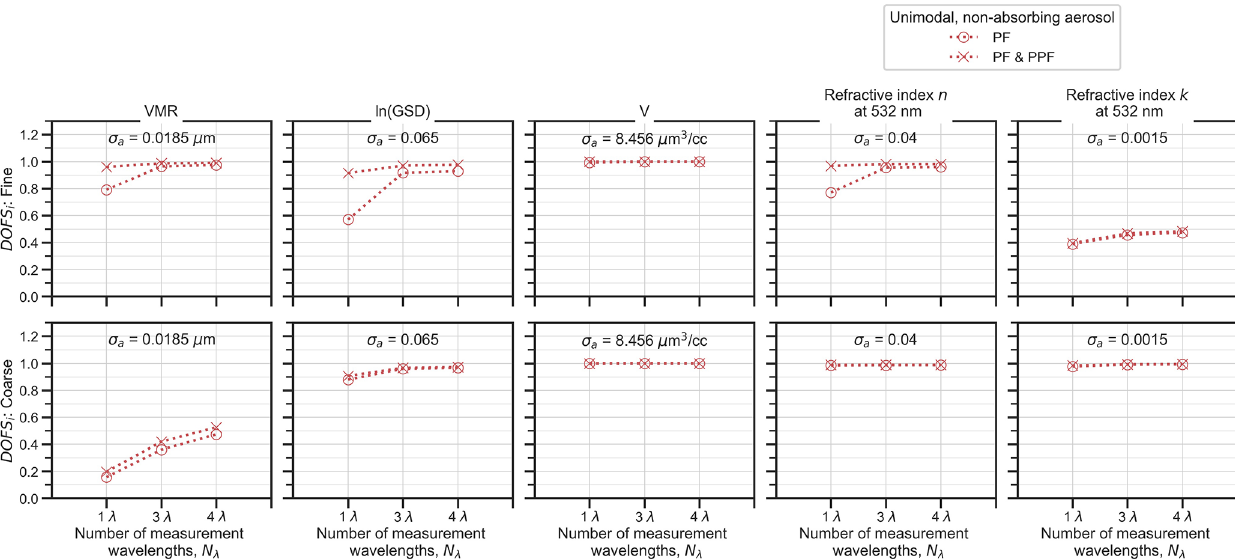
Figure 4. DOFS i values for specific aerosol parameters corresponding to the fine (upper row) and coarse (bottom row) unimodal, non- absorbing-aerosol test cases. The a priori variance values are based on the atmospheric method described in Sect. 3.3 and the measurements from Espinosa et al.